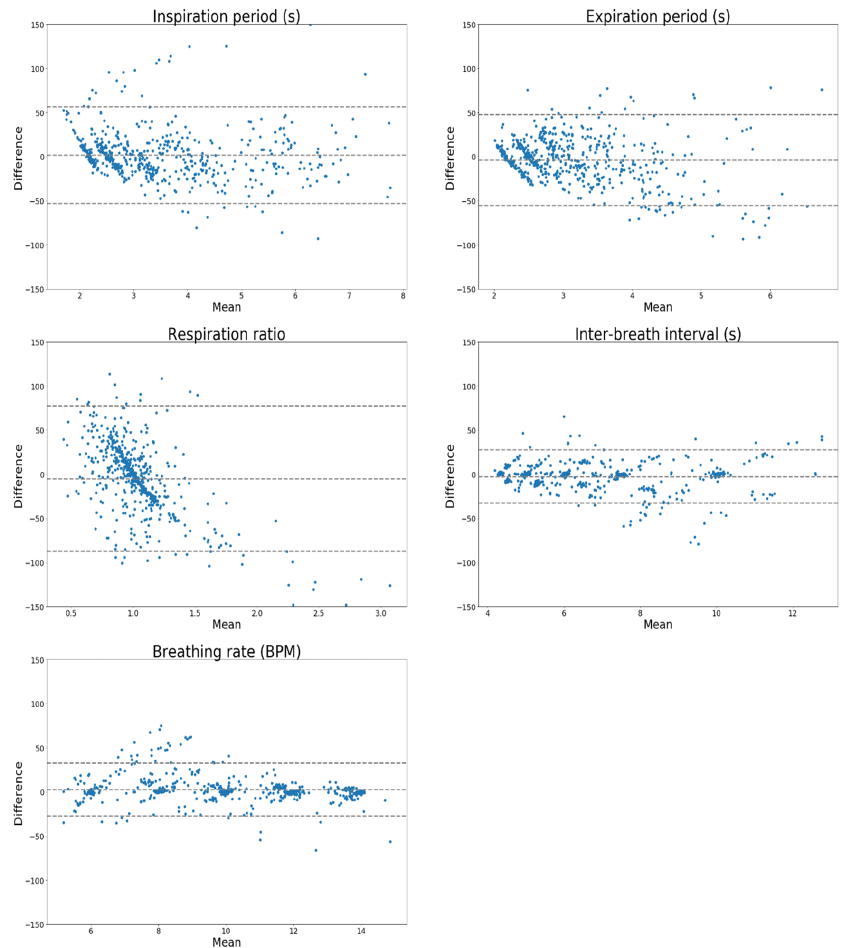
ff erences for LSTM